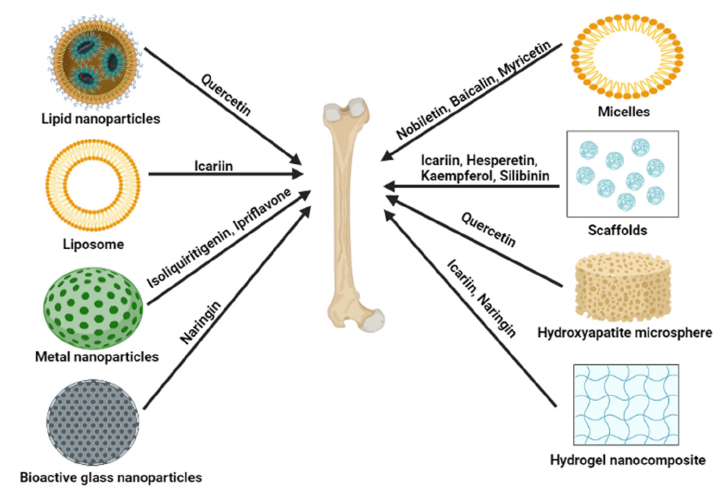
Figure 5. Potential delivery systems for delivering flavonoids to the bone. Figures created with Bi- oRender.com.